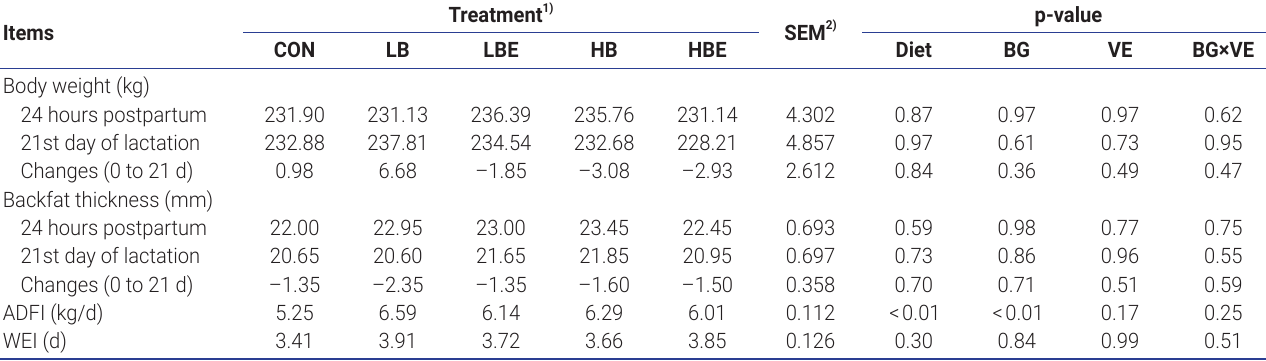
Table 2. Effects of β-glucan with vitamin E supplementation on the physiological response in lactating